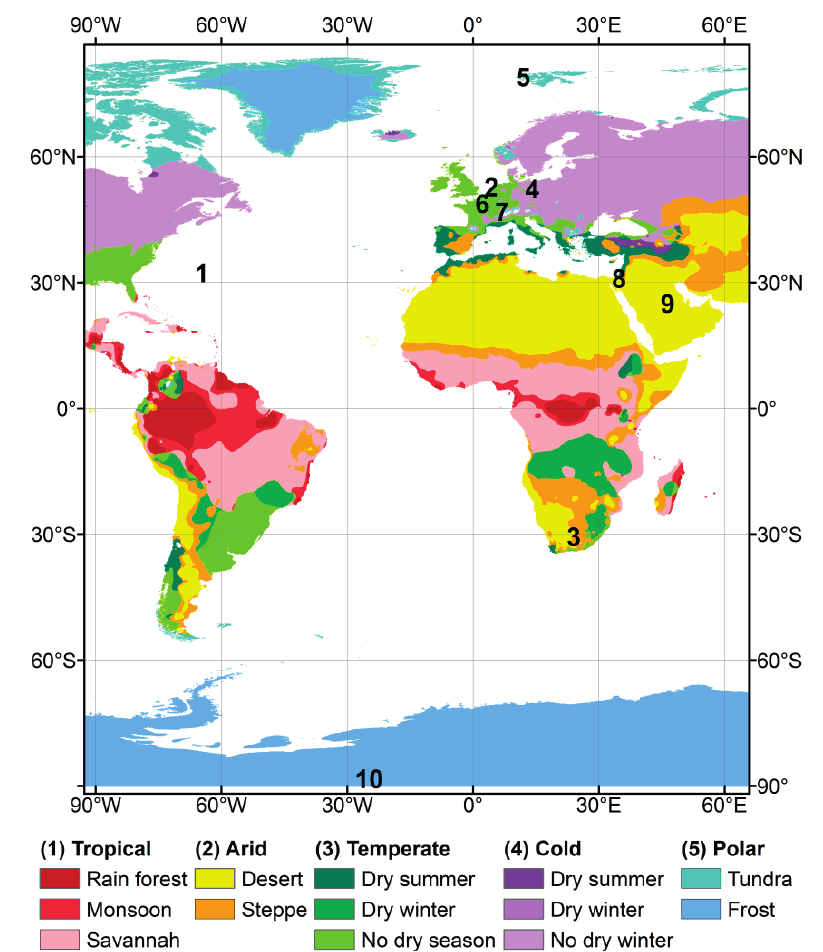
Figure 1. The Baseline Surface Radiation Network (BSRN) sites overlaid on the Köppen-Geiger map of climate zones [36]: 1-Bermuda, 2-Cabauw, 3-De-Aar, 4-Lindenberg, 5-Ny-Ålesund, 6-Palaiseau, 7-Payerne, 8-Sede-Boqer, 9-Solar-Village, and